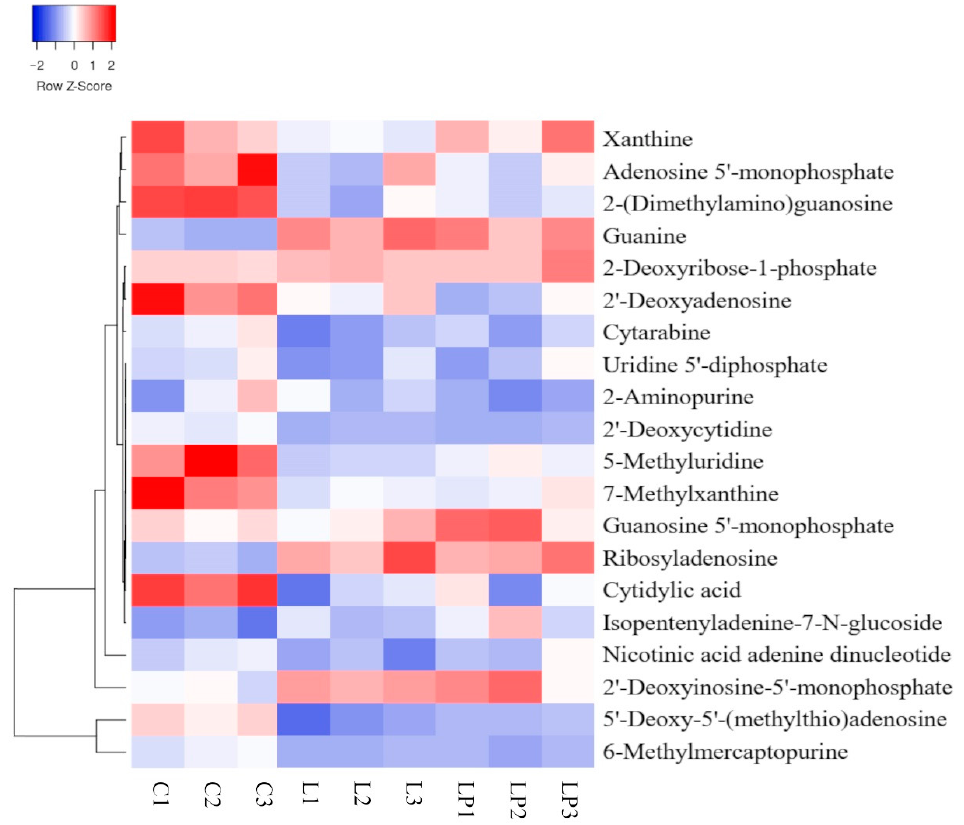
Figure 14. Heatmap and dendrogram of nucleotides and derivatives metabolites in embryos of maize under exogenous proline and low − temperature stress treatments.